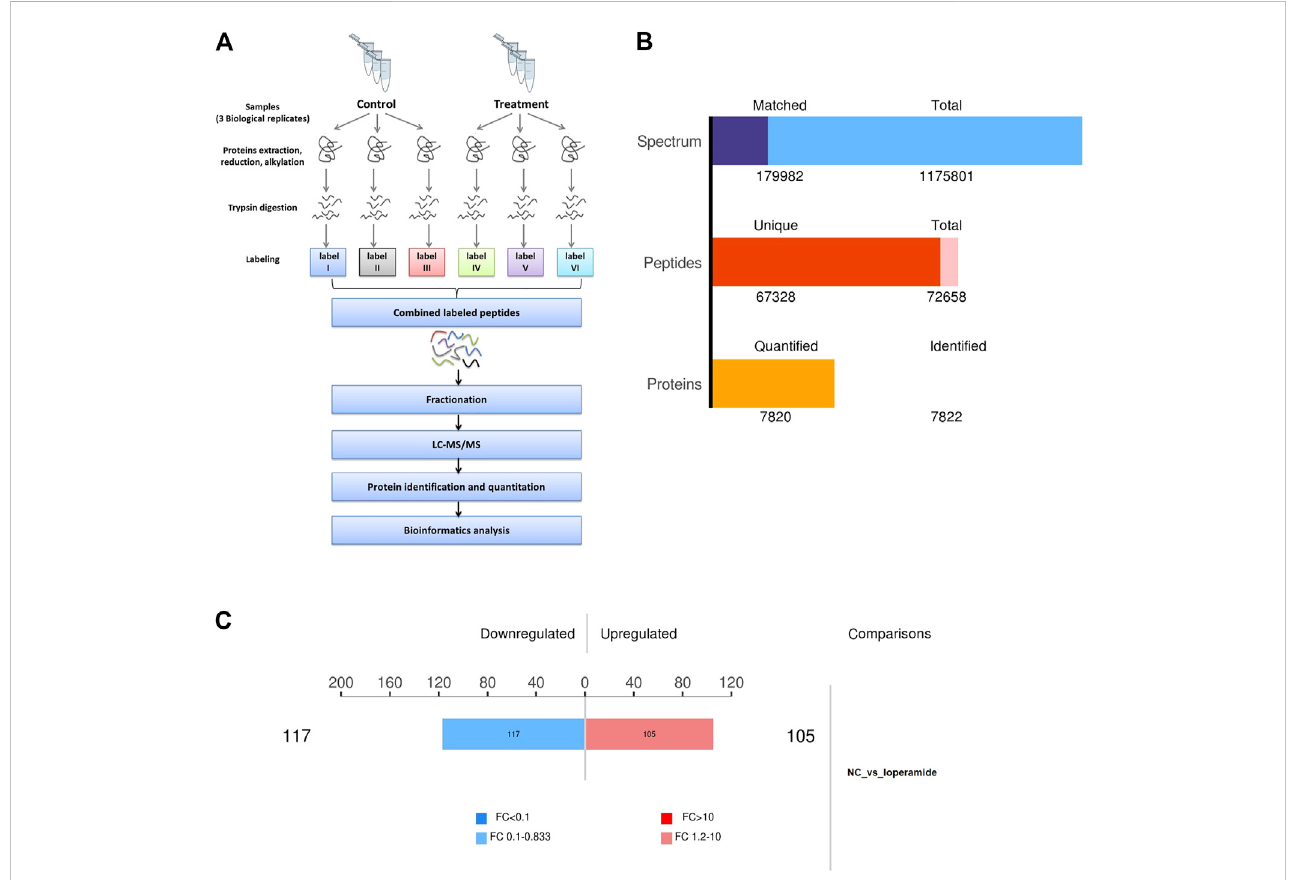
FIGURE 1 Overview of the proteomes of loperamide-treated HT22 cells. (A) Systematic work fl ow of the quantitative proteoome analyses. (B) Statistical histogram of identi fi cation and quanti fi cation results. (C) Histogram of differential protein quanti fi cation results.